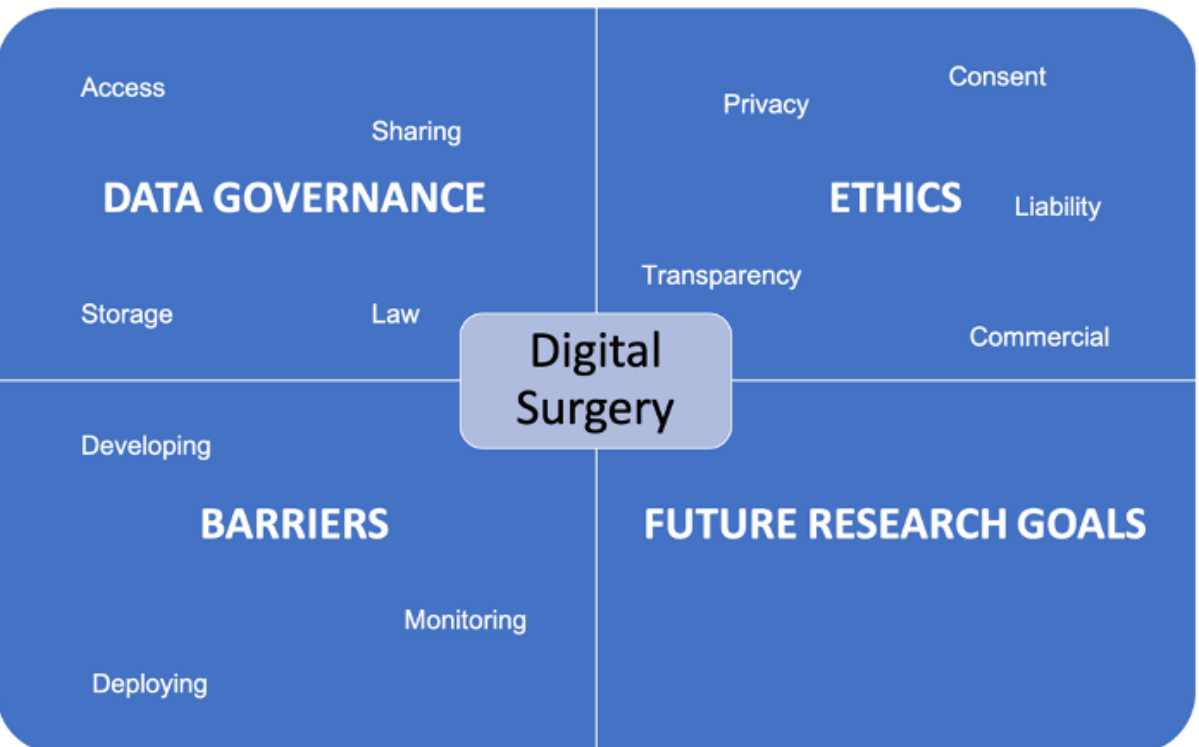
Figure 2. Key domains of round